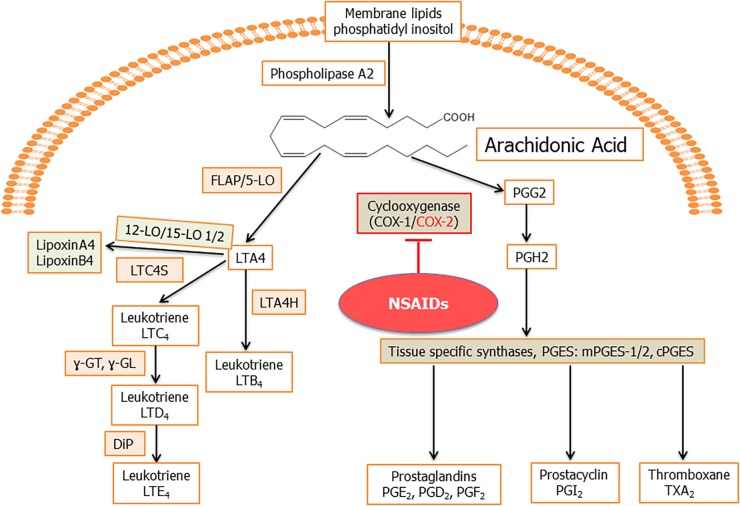
Schematic for arachidonic acid (AA) pathway: phospholipids from the plasma membrane are mobilized and converted to AA by phospholipase A2 (PLA2) enzyme activity. Cyclooxygenase 1 (constitutive) and cyclooxygenase 2 (inducible) enzymes catalyze the synthesis of prostaglandin H2 (PGH2) from AA through an unstable intermediate PGG2 (Vane et al., 1998; Smith et al., 2000). PGH2 is converted by microsomal prostaglandin E synthase (mPGES) to PGE2, which is released in the microenvironment. Besides PGE2, other prostanoids formed from PGH2 include PGI2, TXA2, PGD2, and PGF2α (Hyde and Missailidis, 2009). In human cells, generally, four types of LOs, namely, 5-, 12-, and 15-LO-1 and -2 have been identified. 5LO in conjunction with its activating protein, FLAP, catalyze the dioxygenation of AA into give 5-hydroperoxy eicosapentaenoic acid (5-HpETE). 5LO, with FLAP, then catalyze a second step, the dehydration of 5-HpETE to the intermediate LTA4, that leads to the formation of the leukotrienes and lipoxins (Hyde and Missailidis, 2009). Hydrolysis of LTA4 is catalyzed by LTA4 hydrolase (LTA4H) to produce LTB4. LTA4 is also metabolized by the enzyme LTC4 synthase to produce LTC4, which is acted upon by γ-glutamyl-transpeptidases to yield LTD4. LTD4 is acted upon by a dipeptidase (DiP) to produce LTE4. The combination of LO, -5, -12, or -15 on the same arachidonic acid molecule produces lipoxins.